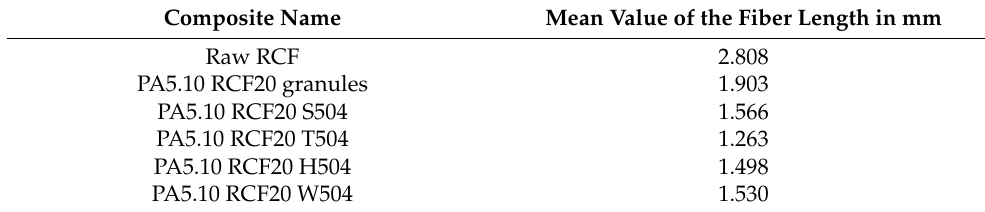
Table 4. Mean values of the fiber lengths of all composites.